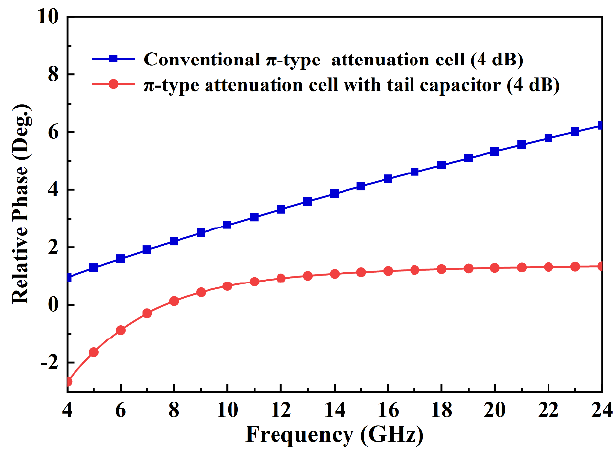
Figure 8. Comparison of the relative phase variation between the conventional and improved π -type attenuation.